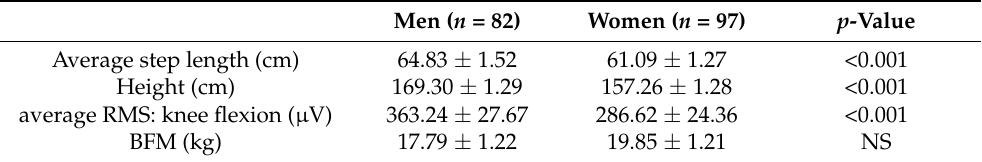
Table 3. Differences in the step length, height, and average RMS value at knee flexion between men and